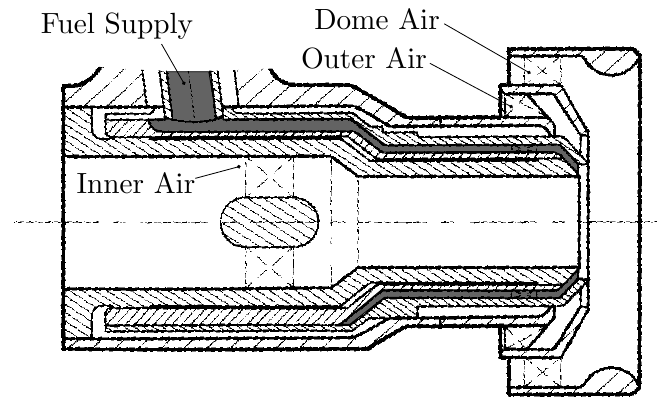
Figure 2. Fuel spray nozzle by Mansour